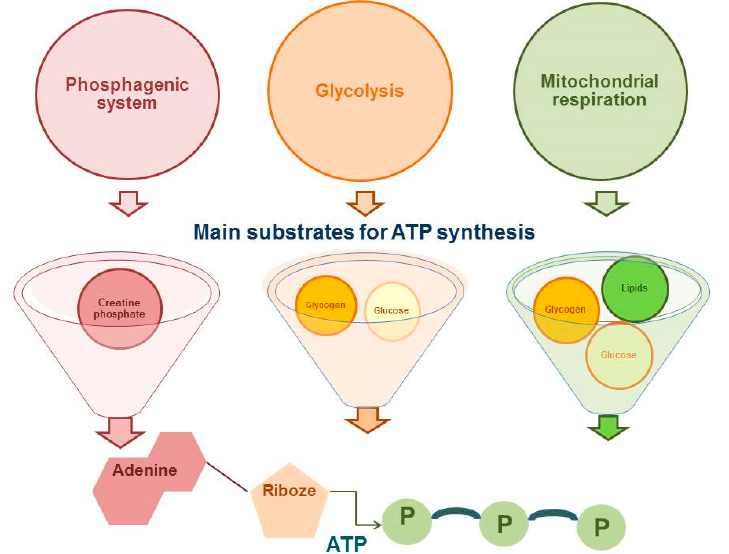
Figure 1. Metabolic pathways of adenosine triphosphate (ATP) synthesis.